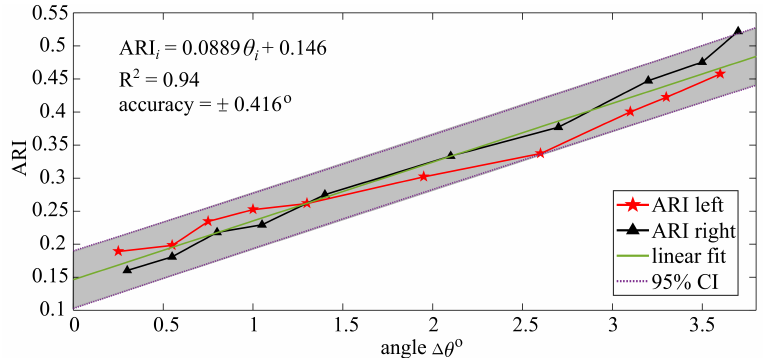
Figure 9. Linear regression of ARI with respect to angular rotation ∆ θ i